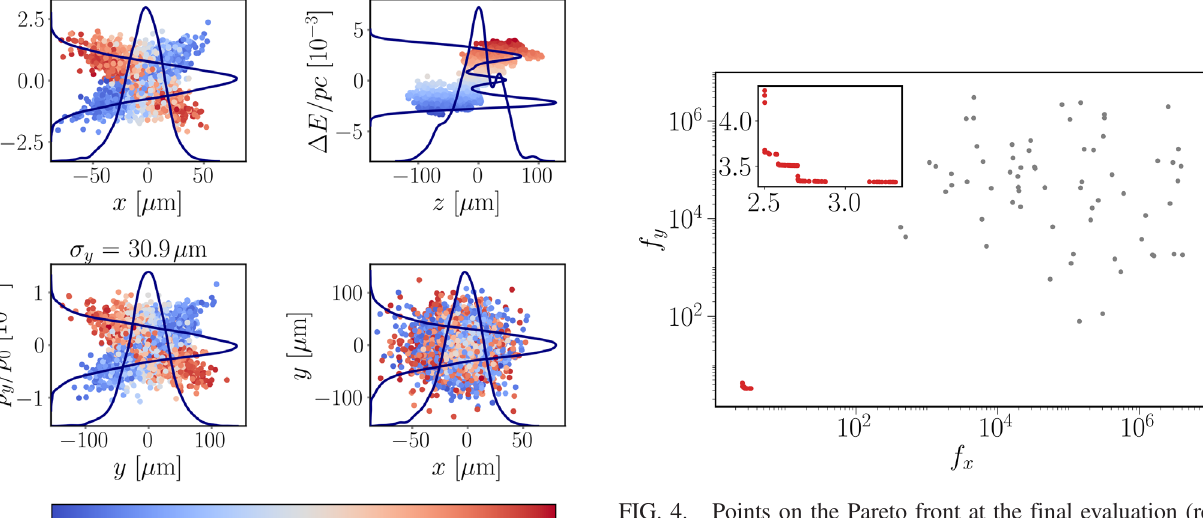
FIG. 4. Points on the Pareto front at the final evaluation (red) and the population from the first evaluation (gray) of the multiobjective optimization of quadrupole strengths and posi- tions; the axes are the two objective functions constructed from the horizontal and vertical components of Eq. (7). The inset shows an expanded view of the final Pareto front. Only viable solutions with no magnet overlap are